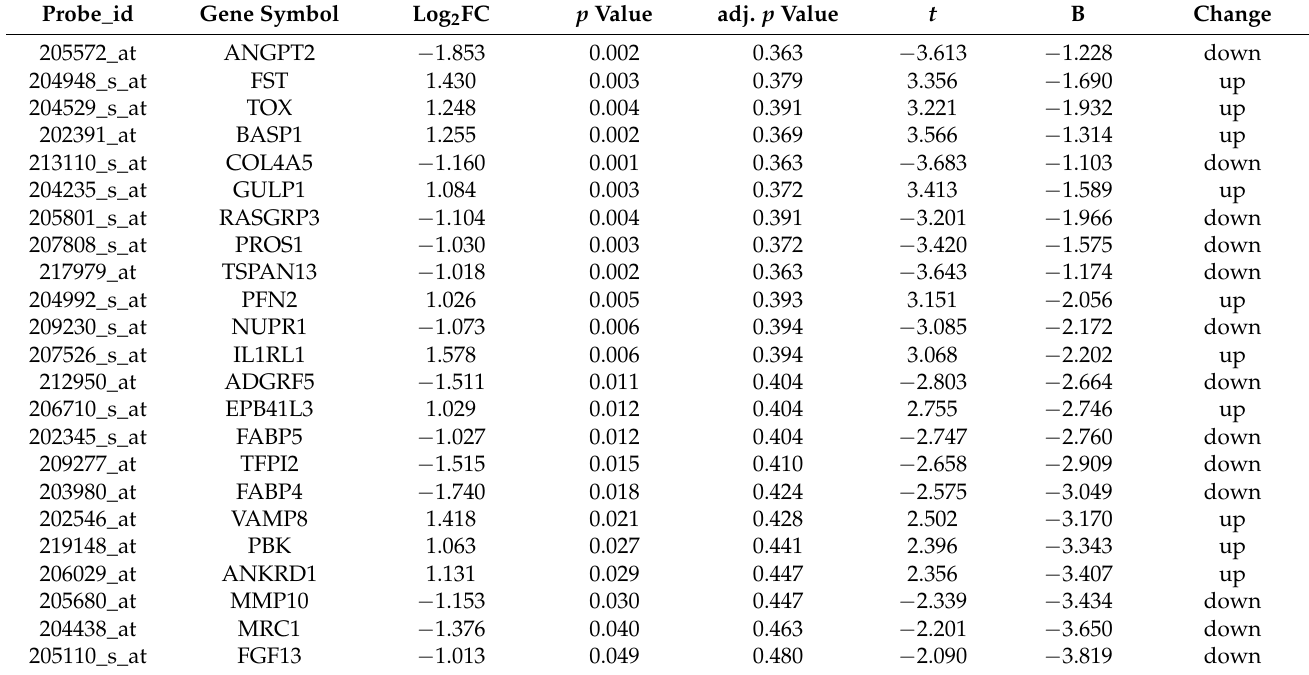
Table 2. Twenty-three genes with significant differences in